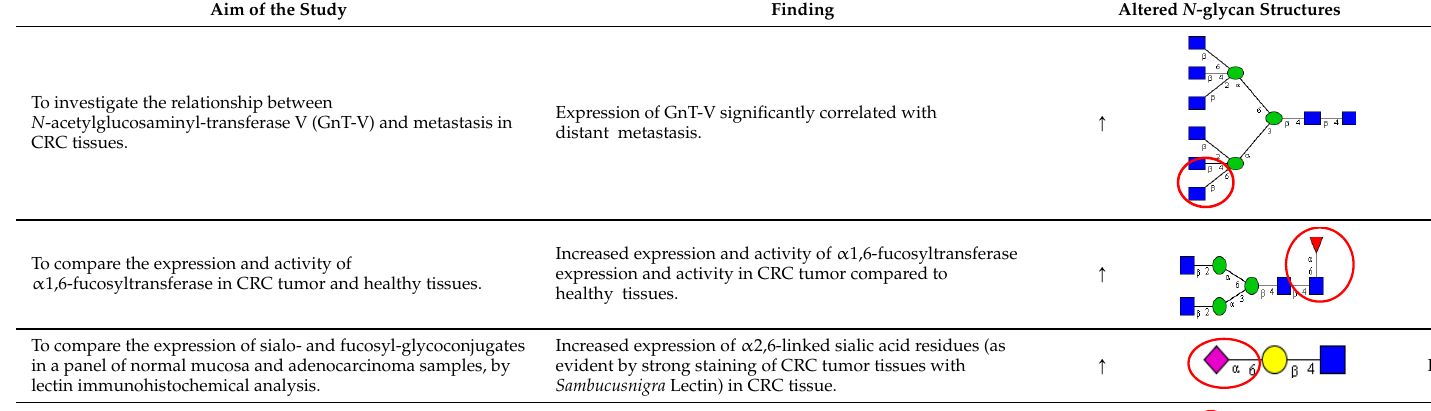
Table 1. N -glycan alterations reported in different studies. Aim of the Study Finding Altered N- glycan Structures